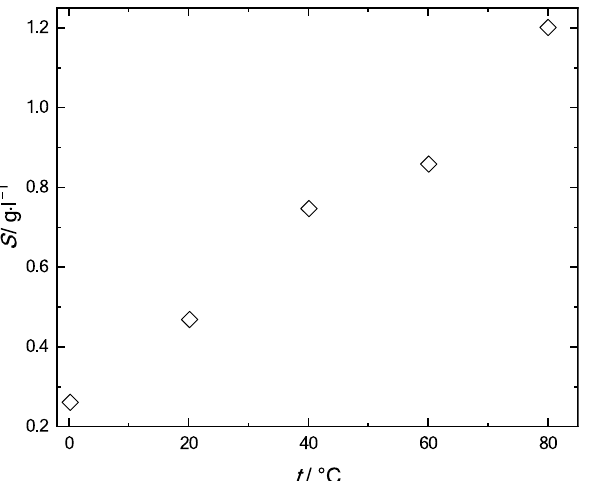
Figure 10. Solubility polytherm of fullerene C 60 in olive oil in the temperature range 0–80 °C.